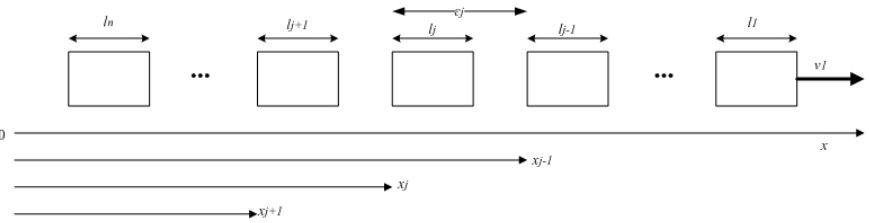
Figure 1. Robots platoon block